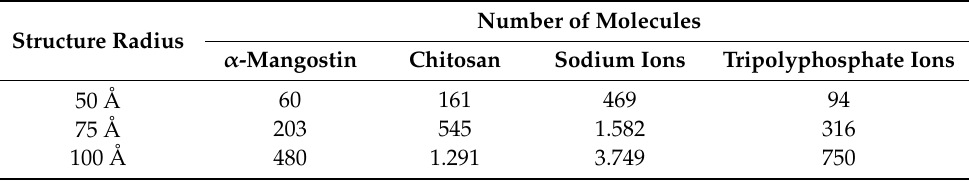
Table 1. Composition of packaging particle structure of the combination of α -mangostin and